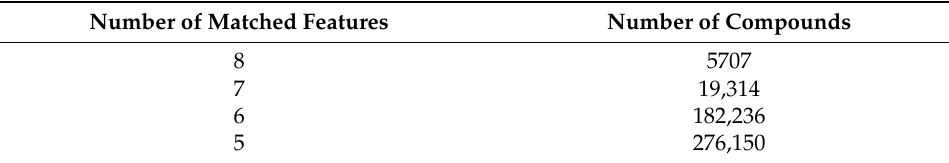
Table 1. Results of the receptor-based pharmacophore screening. Number of Matched Features